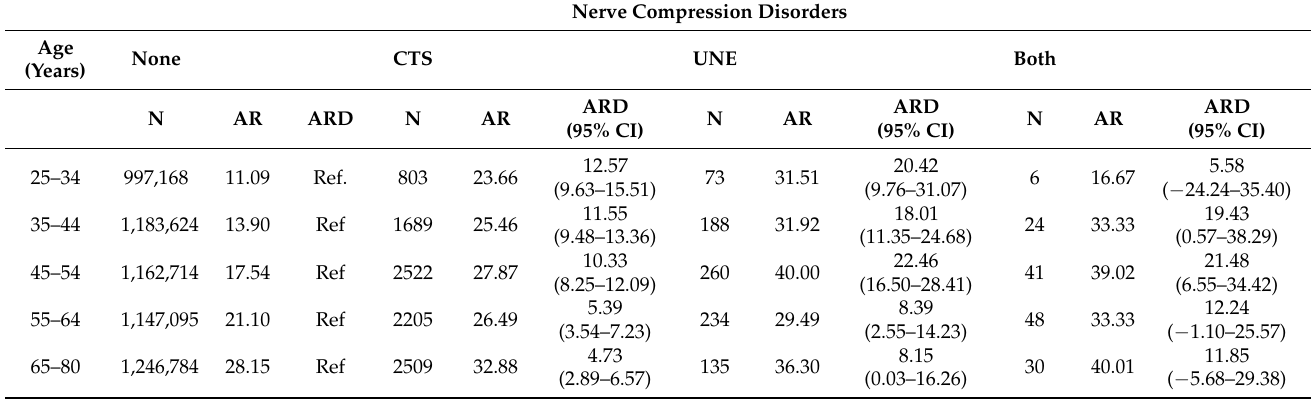
Table 3. Age stratified unadjusted absolute risk (AR), absolute risk difference (ARD) and 95% confidence intervals (CI) of psychotropic medication use during the follow-up in relation to the existence of diagnosed and surgically treated carpal tunnel syndrome (CTS), ulnar nerve entrapment (UNE), or both in the 5,751,152 individuals aged 25–80 years residing in Sweden by 2010. Nerve Compression